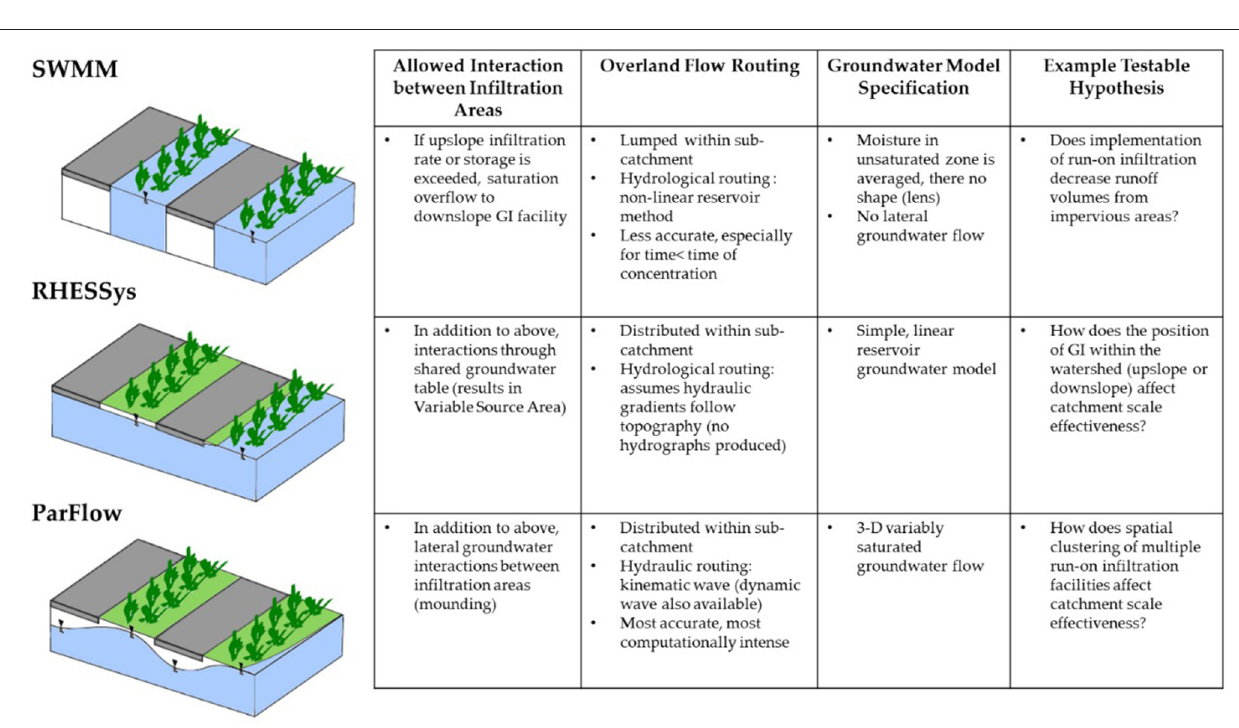
FIGURE 2 | Conceptualization of various hydrological models’ treatment of overland flow routing and groundwater and example testable